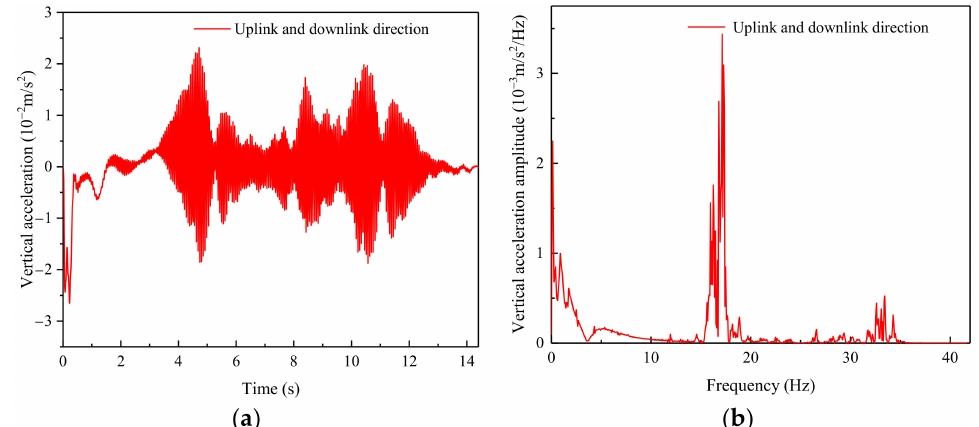
Figure 14. Vertical vibration at point O during the uplink and downlink operations. ( a ) Time history of dynamic acceleration; ( b ) acceleration